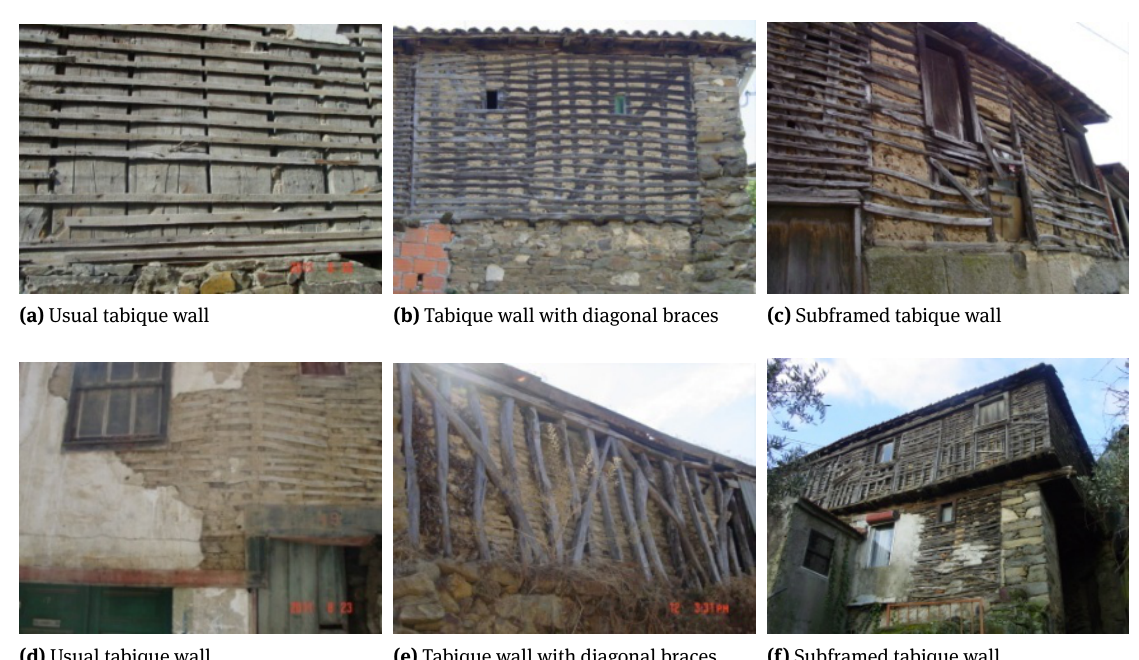
Figure 2: Exterior Tabique walls of tabique dwellings.